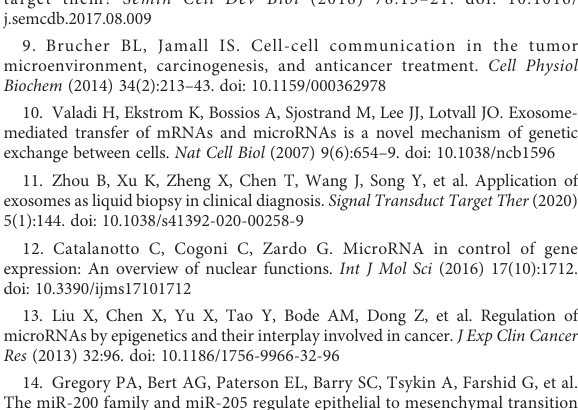
SUPPLEMENTARY FIGURE 1 The expression levels of exosomal miRNAs in EOC patients and healthy donors. (A) miR-375-3p (B) miR-122-5p (C) miR-150-5p (D) miR-125a-5p (E) miR-125b-5p (F) miR-320c (G) miR-320b (H) miR-2110. SUPPLEMENTARY FIGURE 2 Diagnostic role of plasma exosomal miR-320d for EOC patients with lymph node metastasis. (A) The AUCs of exosomal miR-320d was 0.6602 in lymph node metastatic relative to non-metastatic EOC patients. (B) The AUC for the combination of exosomal miR-320d and CA125 was0.7127 in lymph node metastatic relative to non-metastatic EOC patients. (C) The AUC for the combination of exosomal miR-320d, CA125, and HE4 was 0.7367 in lymph node metastatic relative to non-metastatic EOC